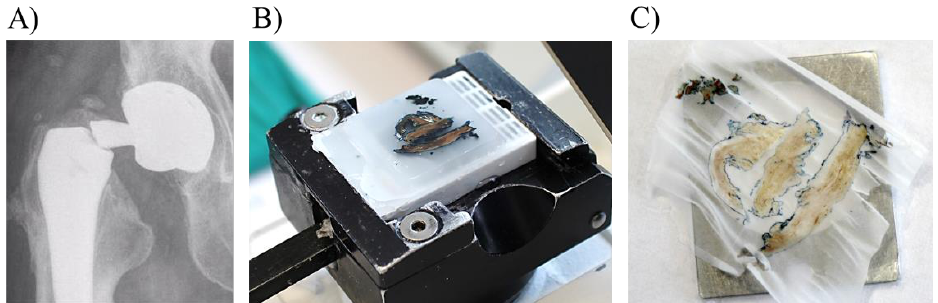
Figure 2. Collection and preparation of periprosthetic tissue slices for multimodal and multiscale analysis. ( A ) X-ray image from fractured modular neck ( B ) paraffin embedded periprosthetic tissue placed in the microtome ( C ) microtome sectioned tissue slice over the aluminium frame with mylar window.